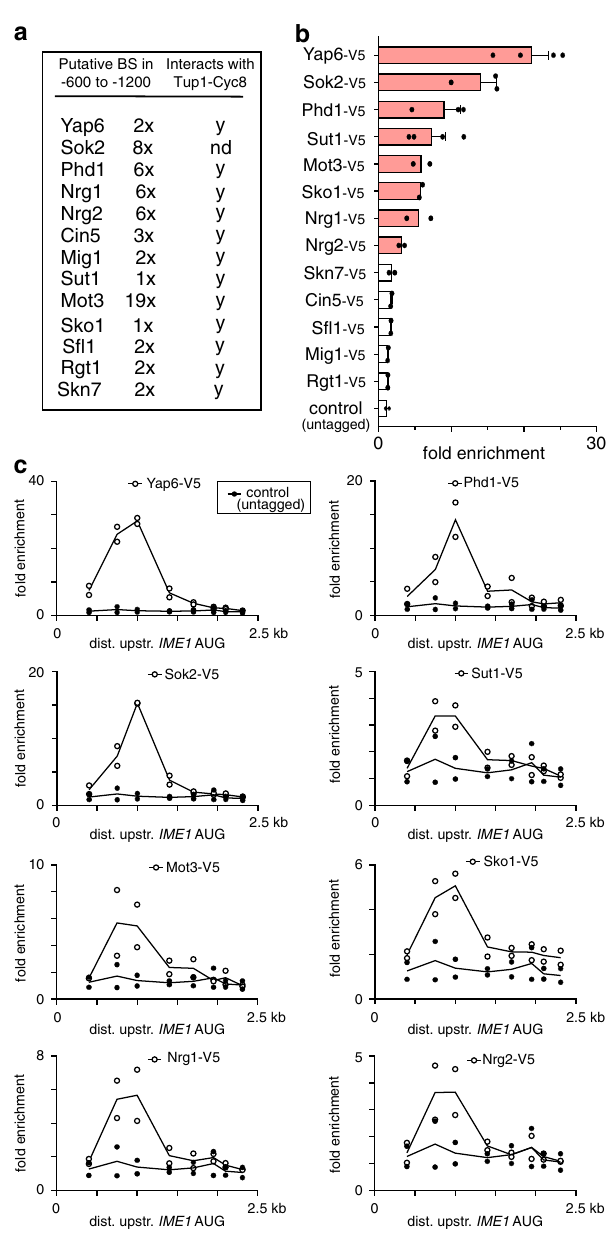
Fig. 2 Multiple Tup1 – Cyc8 interacting TFs associate with the IME1 promoter. a Table of TFs that have been implicated to interact with Tup1 – Cyc8 and have motif sequences within the IME1 promoter. BS = binding site. b Multiple TFs associate with the IME1 promoter in the same region where Tup1 – Cyc8 binds. TFs listed in a were tagged with V5 epitope tag. Diploid cells harbouring V5-tagged transcription factor ( YAP6-V5 , FW3833; SOK2-V5 , FW5638; PHD1-V5 , FW4466; SUT1-V5 , FW6974; MOT3-V5 , FW4383; SKO1-V5 , FW4389; NRG1-V5 , FW4393; NRG2-V5 , FW4396; SKN7-V5 , FW4399; CIN5-V5 , FW7072; SFL1-V5 , FW7070; MIG1- V5 , FW4665; RGT1-V5 , FW4386) and control cells (untagged, FW1511) were grown till exponential growth. The region around 1000 bp upstream of IME1 AUG was analysed for binding by ChIP. The signals were normalised over HMR . Red bars represent a signal of three-fold over HMR or more. Mean and SEM of n = 4 (Yap6-V5 and Sut1-V5), n = 3 (Sok2-V5 and Phd1- V5) and n = 2 for other TFs plus untagged control are shown. c Similar as b , except that TFs that showed at least three-fold enrichment in b were analysed for binding throughout the whole IME1 promoter. Eight primer pairs were used for the analyses. The mean of n = 2 is